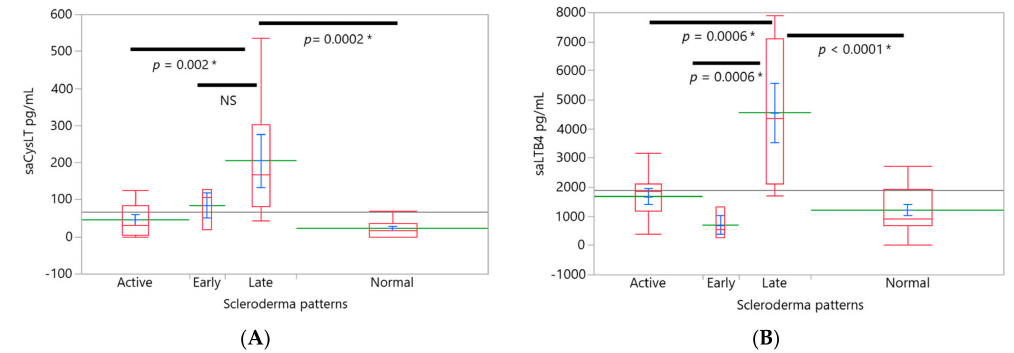
Figure 4. LT levels and capillaroscopy scleroderma patterns. Levels of leukotrienes were associated with scleroderma patterns. Box plots (red), mean (green), mean error bars (blue) and grand mean (grey line across the boxes) are shown. Overlap marks are drawn to illustrate statistical differences between the groups. The X axis is proportional. Levels of salivary CysLTs ( A ) and LTB4 ( B ) were higher in the group with “late” pattern compared to normal and active nailfold capillaroscopy. In addition, levels of salivary LTB4 in “late” pattern were higher than in the “early” pattern. Analysis of covariance (ANCOVA) was used for analysis and Tukey HSD test was used to detect the differences between all pairs. saCysLT: salivary cysteinyl-leukotrienes, saLTB4: salivary leukotriene B4. *: to denote statistical